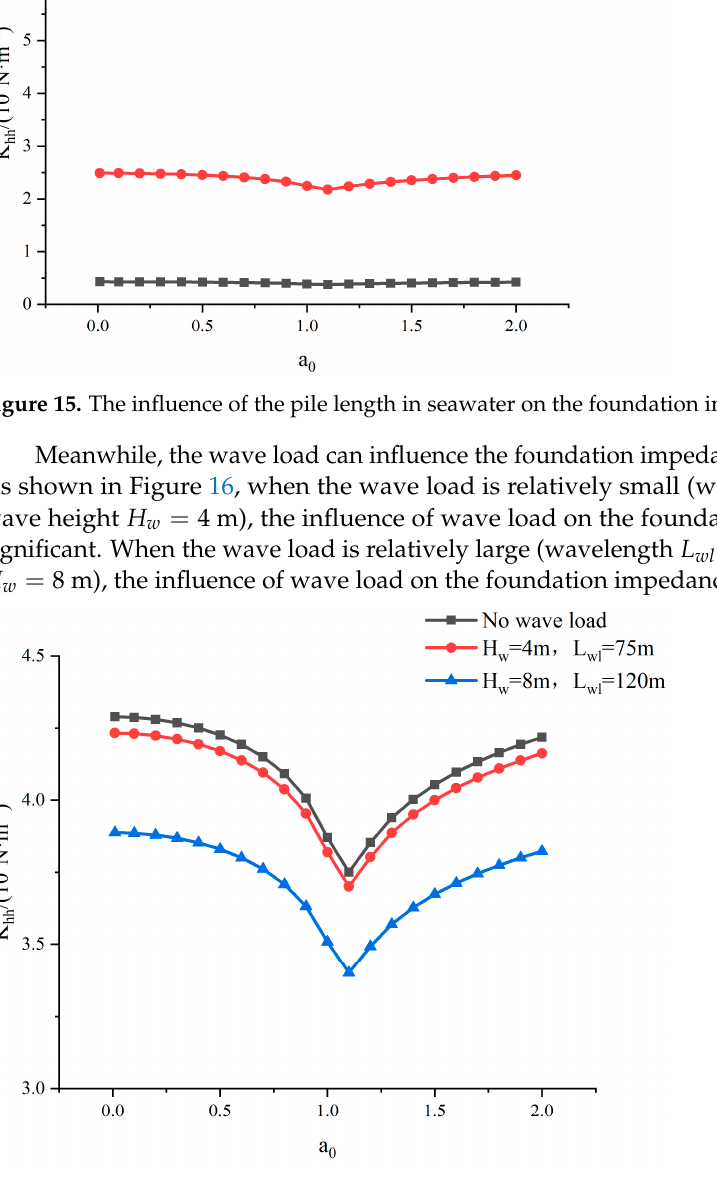
Figure 16. The influence of the wave load on the foundation impedance.